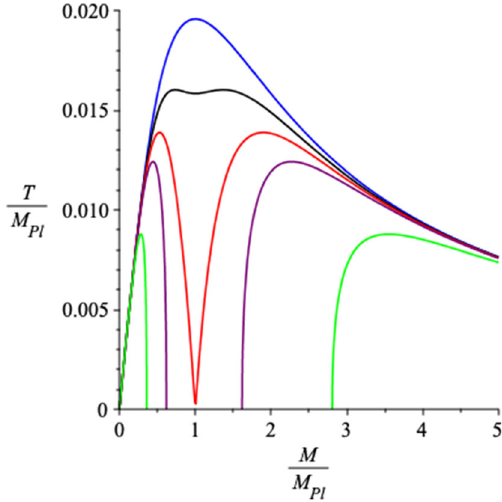
Fig. 10 Hawking temperature for the GUP-Kerr black hole for β = 2. Curves correspond to the parameters n = 1 (blue), 3 (black), 4 (red), 5 (purple) and 10 (green). The critical value n = 4 introduces a phase transition, similar to that for the extremal RN-GUP black hole, beyond which there is a mass gap with no black holes. T = 0 endpoints in the super-Planckian regime correspond to stable spinning